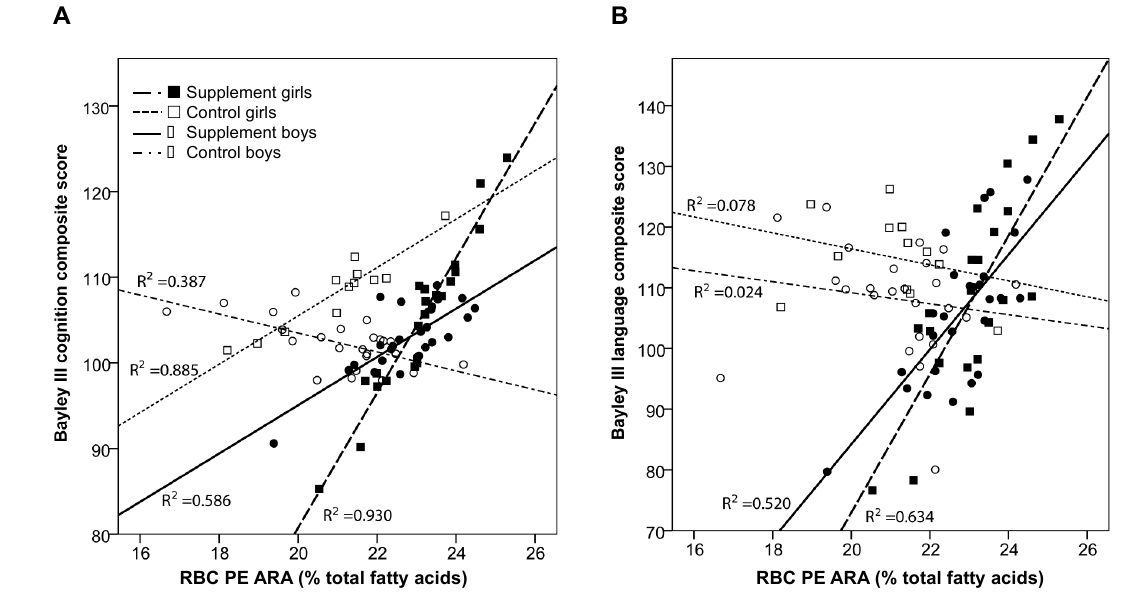
Figure 2. Relationship between RBC PE arachidonic acid (ARA) level and: ( A ) Bayley III cognitive composite scores; and ( B ) Bayley III language composite scores at age 24 months by supplement group and sex (supplement-treated girls ( (cid:4) ); control-treated girls ( (cid:3) ); supplement-treated boys ( ); and control-treated boys ( )).